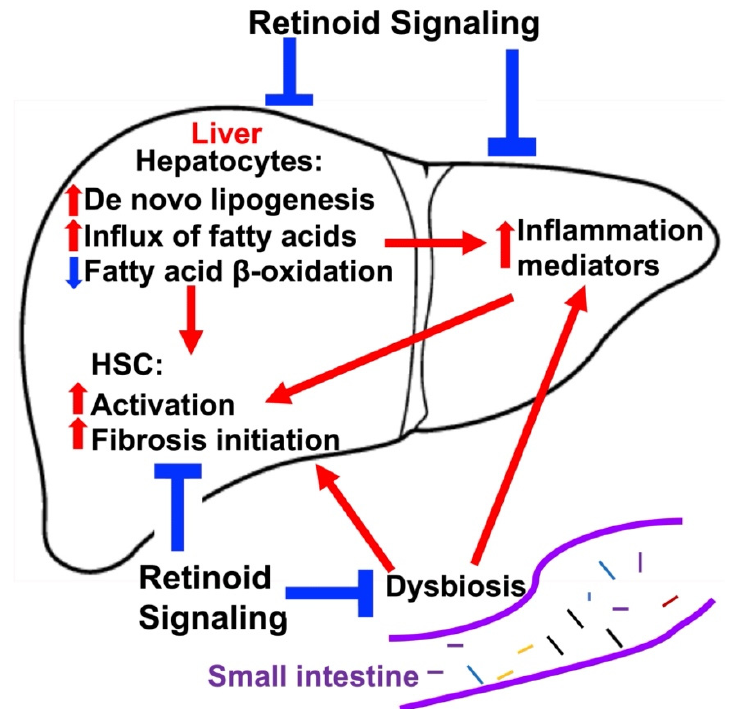
Figure 2. Retinoid actions in nonalcoholic fatty liver disease (NAFLD) and alcohol-related liver disease (ALD). De novo lipogenesis and free fatty acid influx contribute to liver steatosis manifested in both NAFLD and ALD. Liver-steatosis-induced lipotoxicity and dysbiosis in the gut results in hepatic inflammation and hepatic fibrosis. Retinoid signaling inhibits these events and attenuates these events, which can cause liver injury. Upward red arrows and downward blue arrow indicate increases and decreases, respectively. Abbreviations: HSC: hepatic stellate cell.